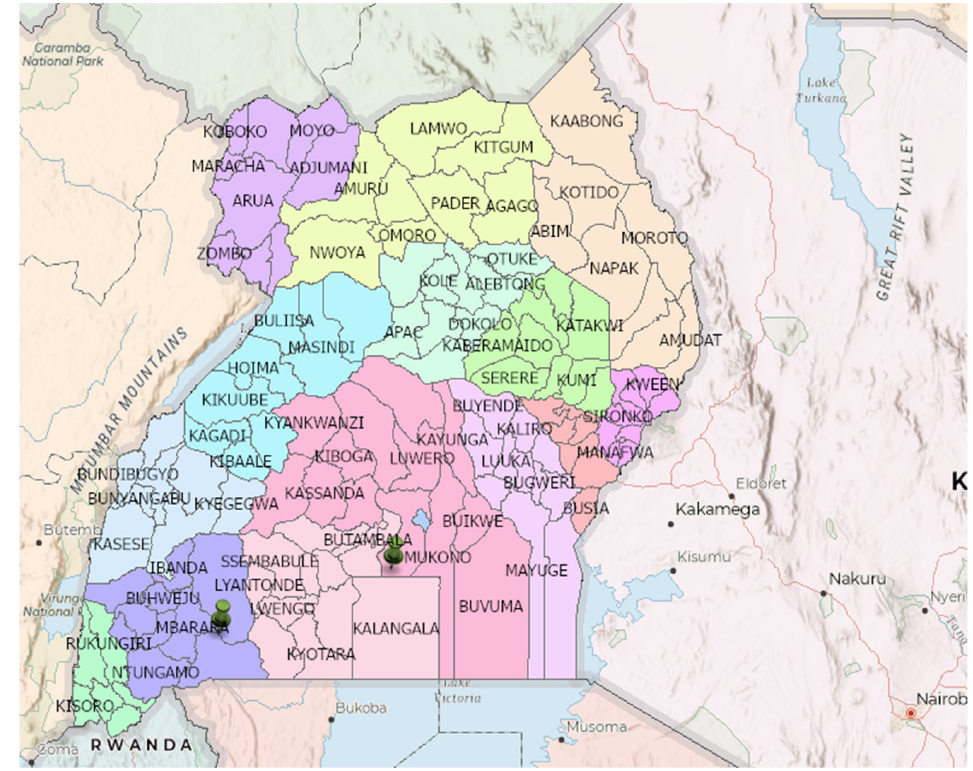
Figure 2. Map of Uganda showing districts of study (green pushpins).